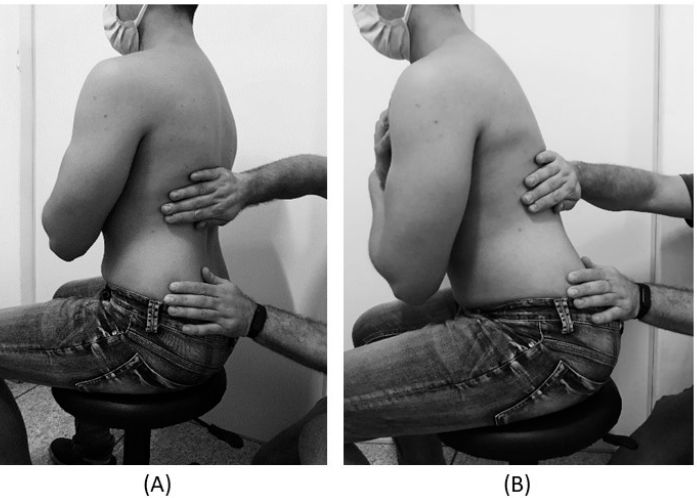
Figure 2. ( A ) Trunk position (90°) and researcher’s hands contact at the beginning of the technique. ( B ) 30° trunk flexion and researcher’s hands contact at the end of the technique.